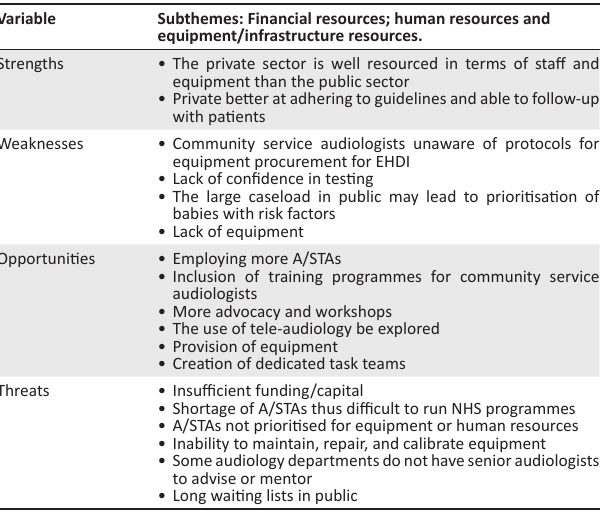
TABLE 2: Strengths, weaknesses, opportunities, and threats for theme 2: Investment in resources and infrastructure for early hearing detection and